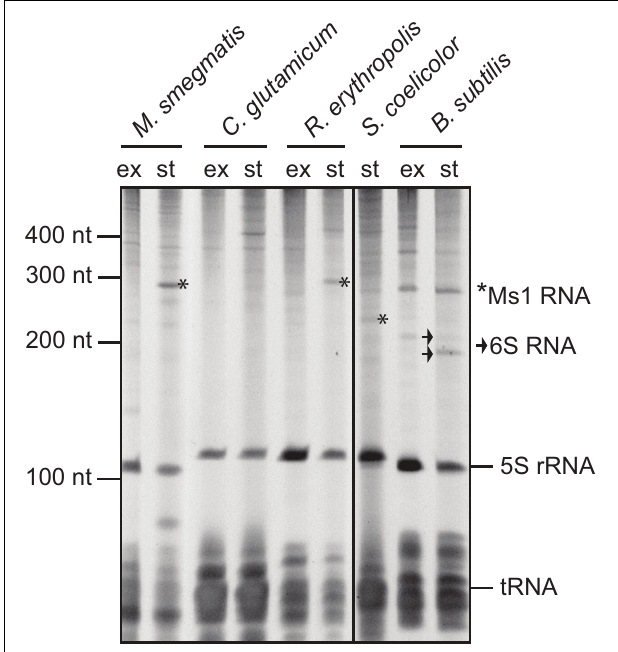
FIGURE 4 | Total RNA isolated from Mycobacterium smegmatis mc 2 155, Corynebacterium glutamicum , Rhodococcus erythropolis CCM2595, Streptomyces coelicolor A3(2), and Bacillus subtilis from exponential (“ex”) and stationary (“st”) phase of growth, resolved on polyacrylamide gel electrophoresis and stained with GelRed. Ms1 RNAs in M. smegmatis and R. erythropolis and a band corresponding to the size of Str13/Ms1 in S. coelicolor are labelled with *. Two forms of B. subtilis 6S-1 RNA are marked by arrow.